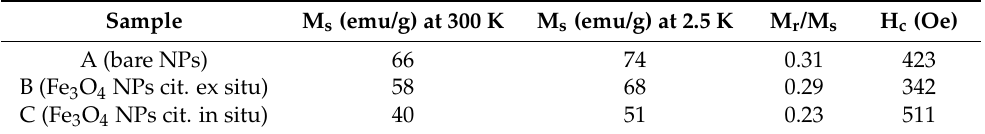
Table 4. Saturation magnetization M s measured at 300 K and 2.5 K, ratio of the residual (M r ) and M s at 2.5 K, coercitive field (Oe) at 2.5 K for the three samples. Sample A (bare